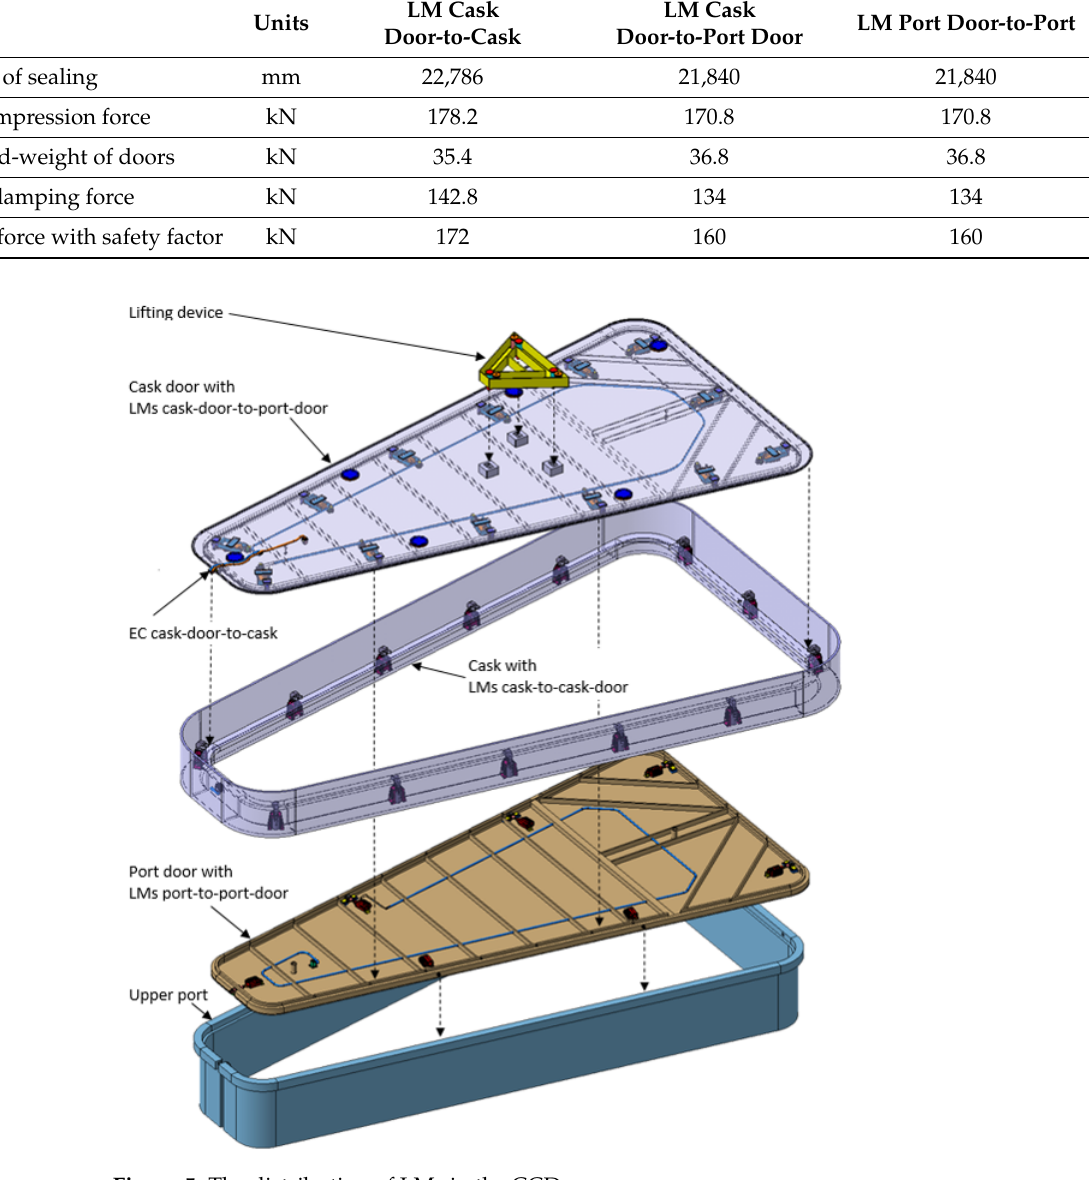
Figure 5. The distribution of LMs in the